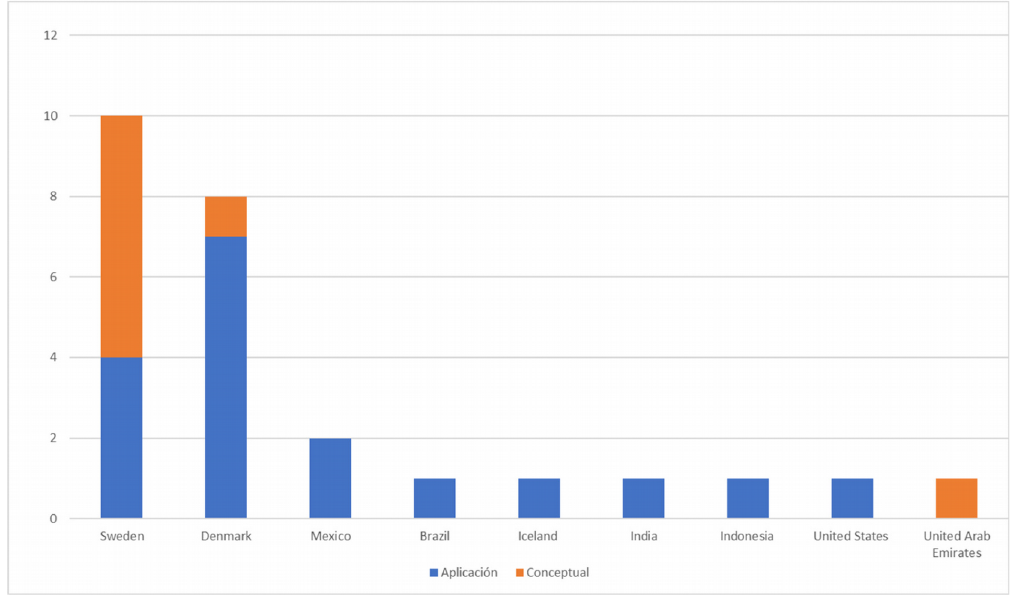
Figure 3. Distribution of products by country